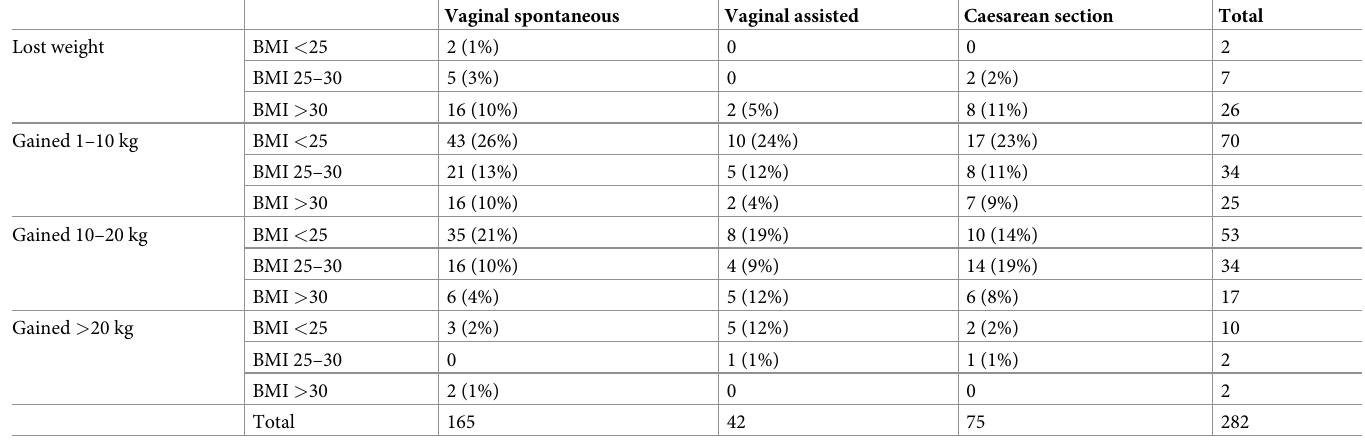
Table 2. Birth outcomes stratified according to pre-pregnancy BMI and absolute GWG. Vaginal spontaneous Vaginal assisted Caesarean section Total Lost weight BMI < 25 2 (1%) 0 0 2